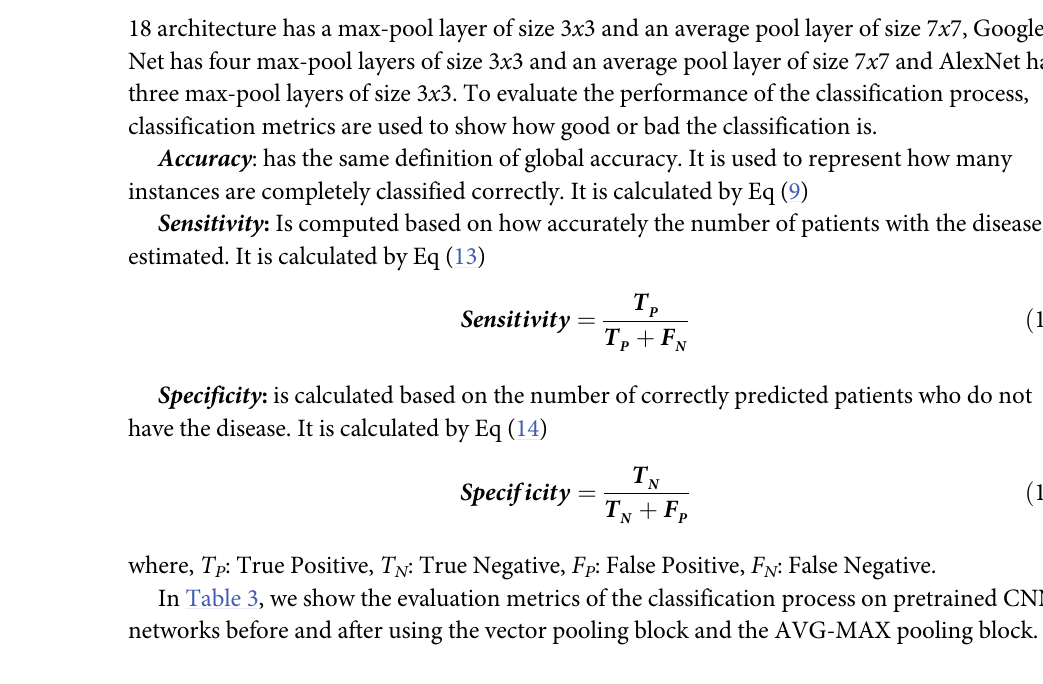
Fig 7. Illustrative chart for the evaluation metrics of the semantic segmentation process with U-net before and after using the VPB and AVG-MAX VPB presented in Table 2.